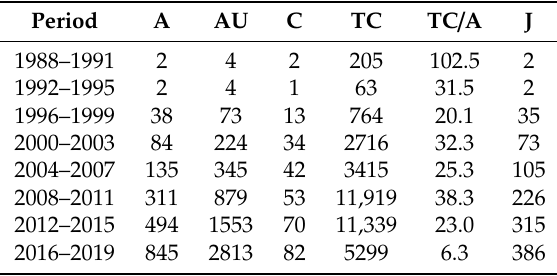
Table 2. Main characteristics of scientific production (1998–2019).